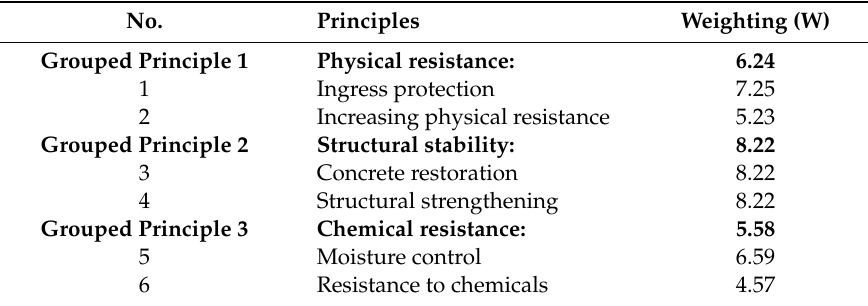
Table 4. Weighting of grouped and component repairing principles.